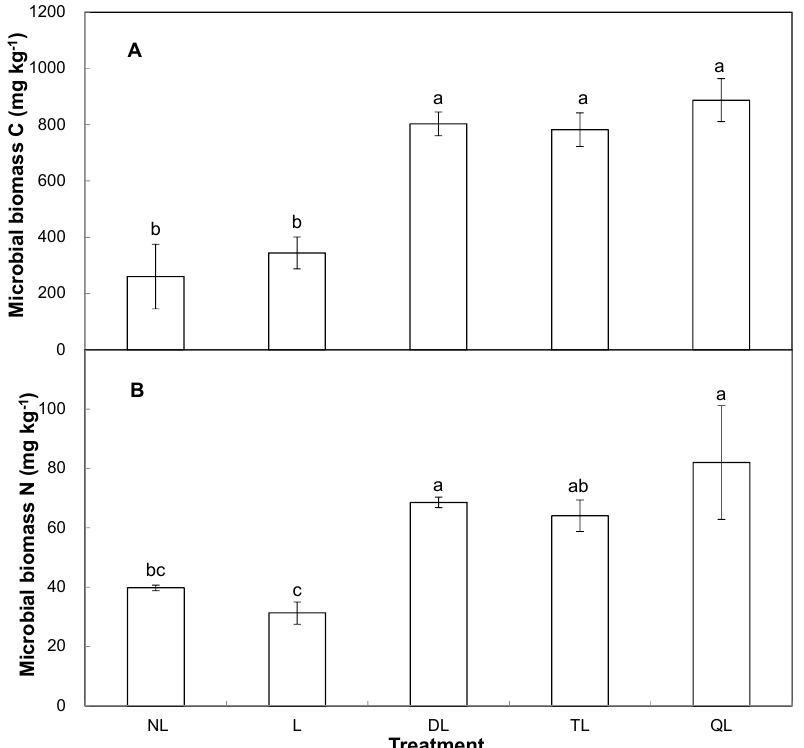
Figure 3. Effects of litter quantity on soil microbial biomass carbon ( A ) and nitrogen ( B ). Different letters indicate significant differences between treatments at p < 0.05. Values are presented as the means ± standard error. See Figure 1 for abbreviations.